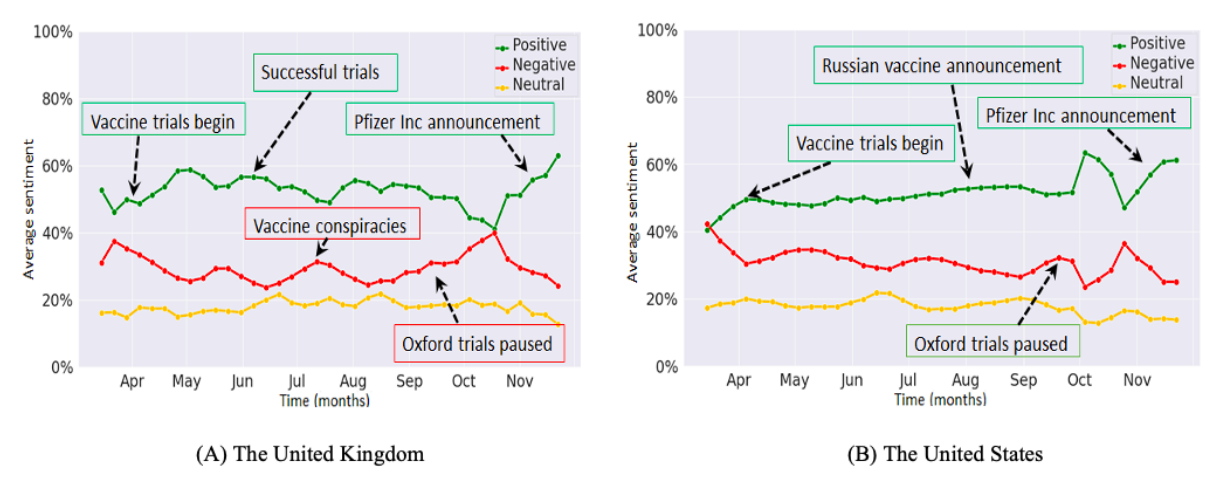
Figure 3. Average weekly trends in Twitter sentiments for (A) the United Kingdom and (B) the United